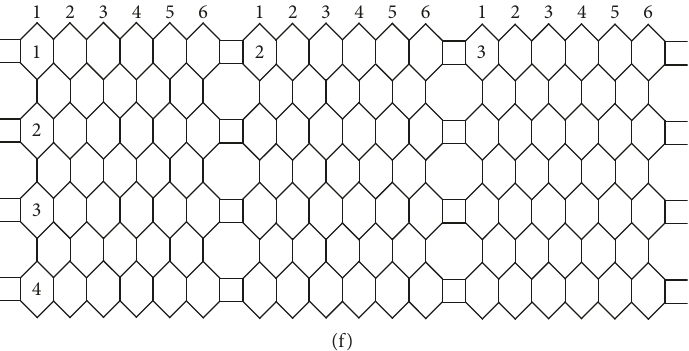
Figure 3: The molecular graphs of t -polyacenic nanotubes P t